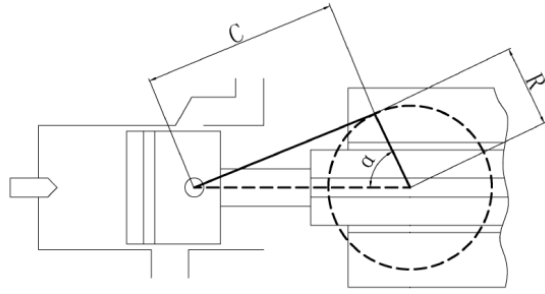
Figure 4. The configuration of the conventional engine.